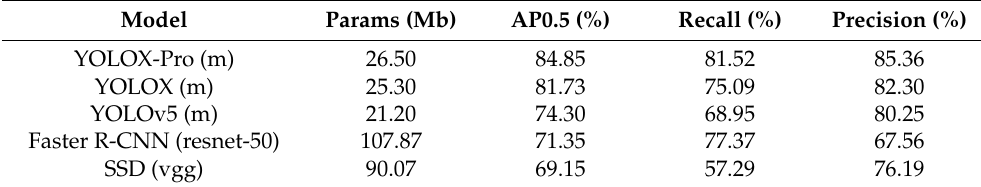
Table 5. Comparison of detection performance of different models.